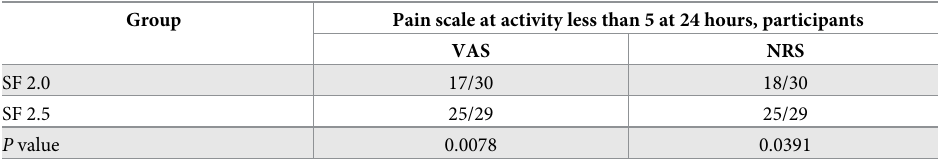
Table 3. Pain score at activity less than 5.0 at 24 hours after